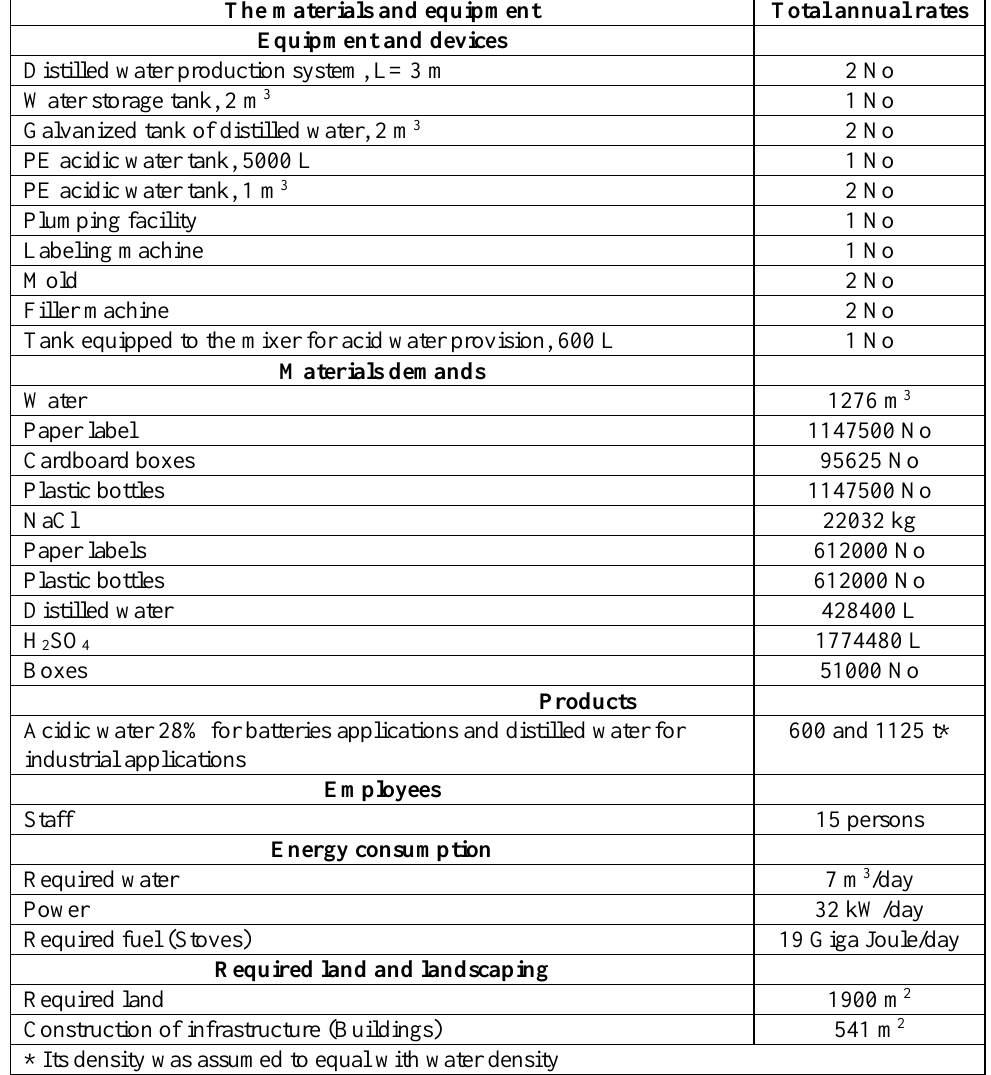
Table 2: The annual requirements of industries of acidic water 28% and distilled water (nominal capacity of 600 and 1125 t). The materials and equipment